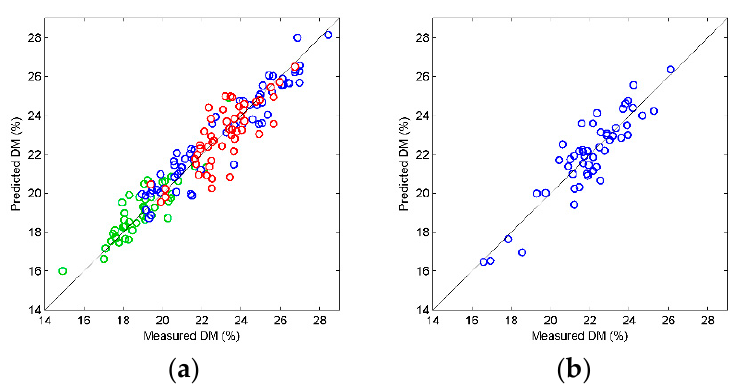
Figure 5. ( a ) Predicted versus measured dry matter content for cross validated calibration model. Colors refer to the different potato varieties: Innovator (blue), Oleva (green), Folva (red). ( b ) Predicted dry matter in test set measured on industrial conveyor belt. Values are slope and offset corrected.